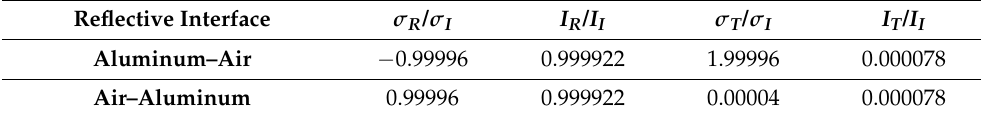
Table 3. Acoustic reflection and transmission ratio of the aluminum–air interface. Reflective Interface